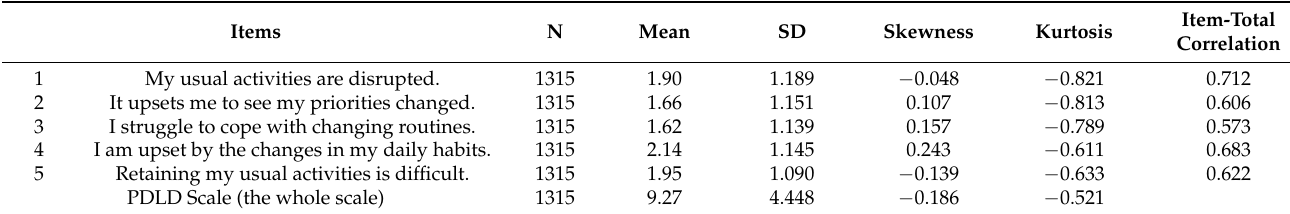
Table 2. PDLD scale—descriptive